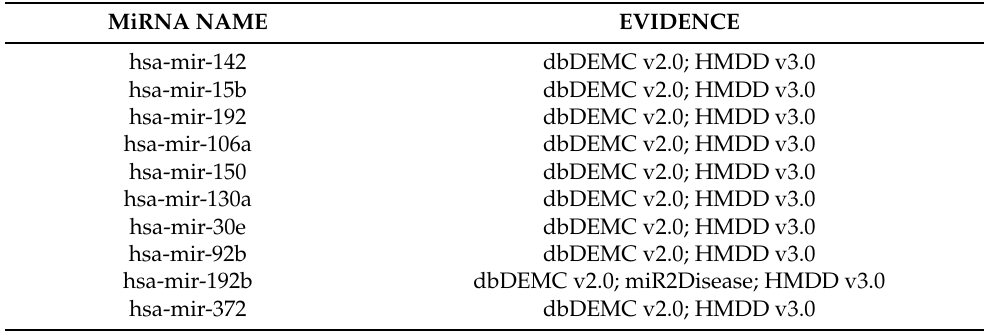
Table 8. Top 10 predicted miRNAs associated with breast neoplasms.